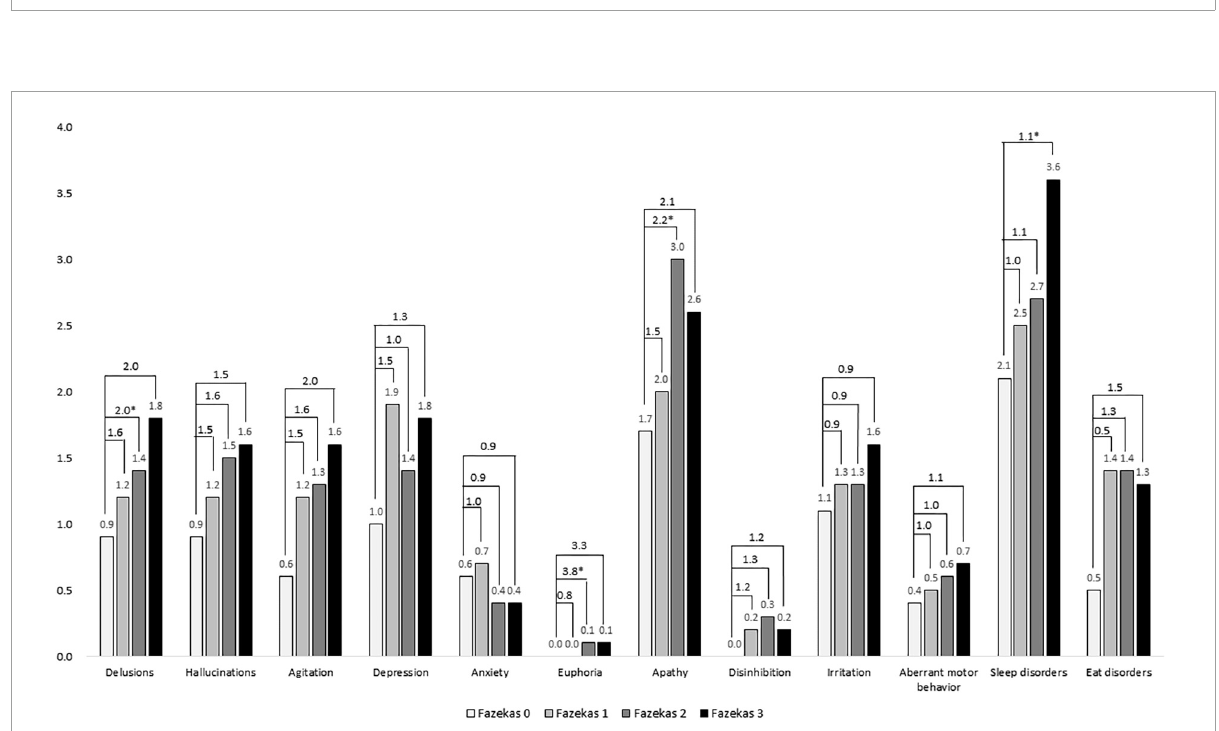
FIGURE3 Comparison of composite scores of neuropsychiatric symptoms in the NPI among different Fazekas groups adjusted for age, sex, education, and disease duration. ORs were compared to Fazekas score of 0. ∗ p <